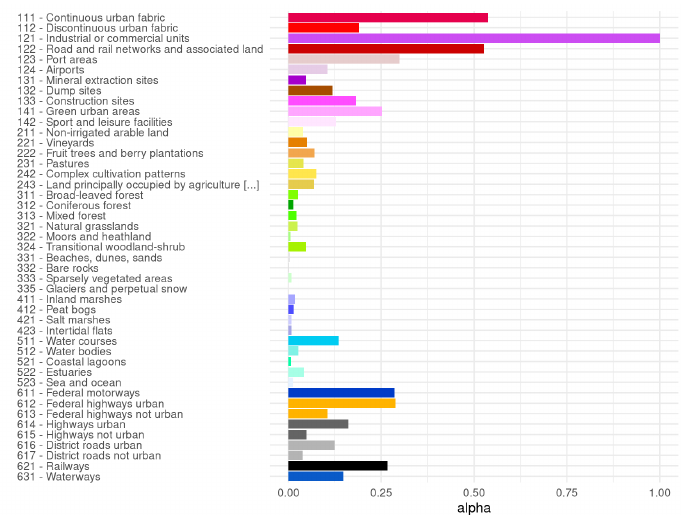
Figure 3. Level 3 CORINE land cover classes with their number, name, and emission land use coefficient α (alpha). Classes 611–631 were manually generated and added (see Section